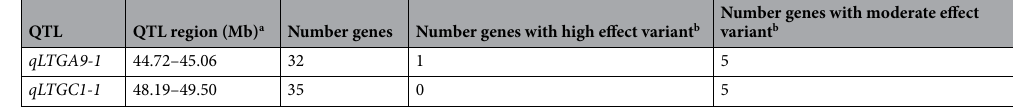
Table 4. Candidate genes located in the intervals of qLTGA9-1 and qLTGC1-1 . a QTL region defined as union of QTL-seq and linkage mapping credible intervals. b Functional effects of variants (moderate or high) determined by snpEff tool.